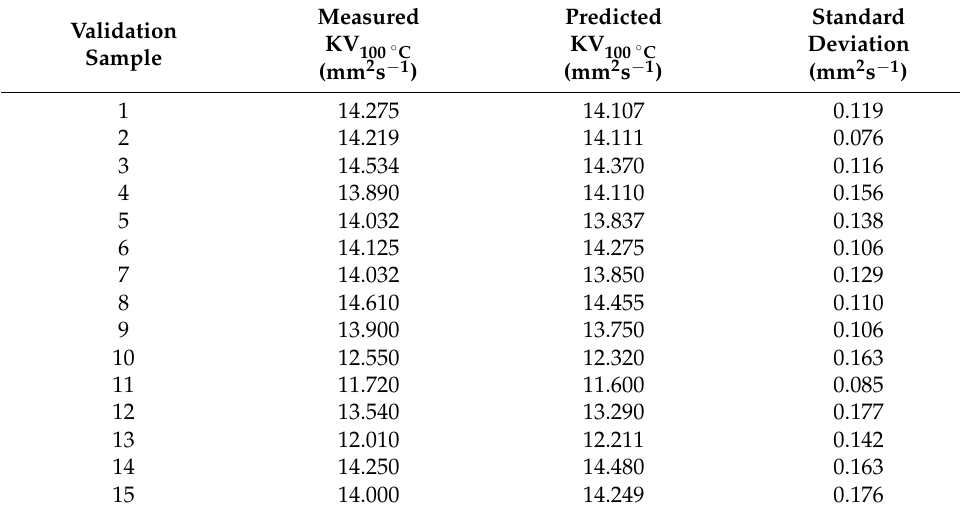
Table 2. Results of external validation of the best FTIR-PLS model.